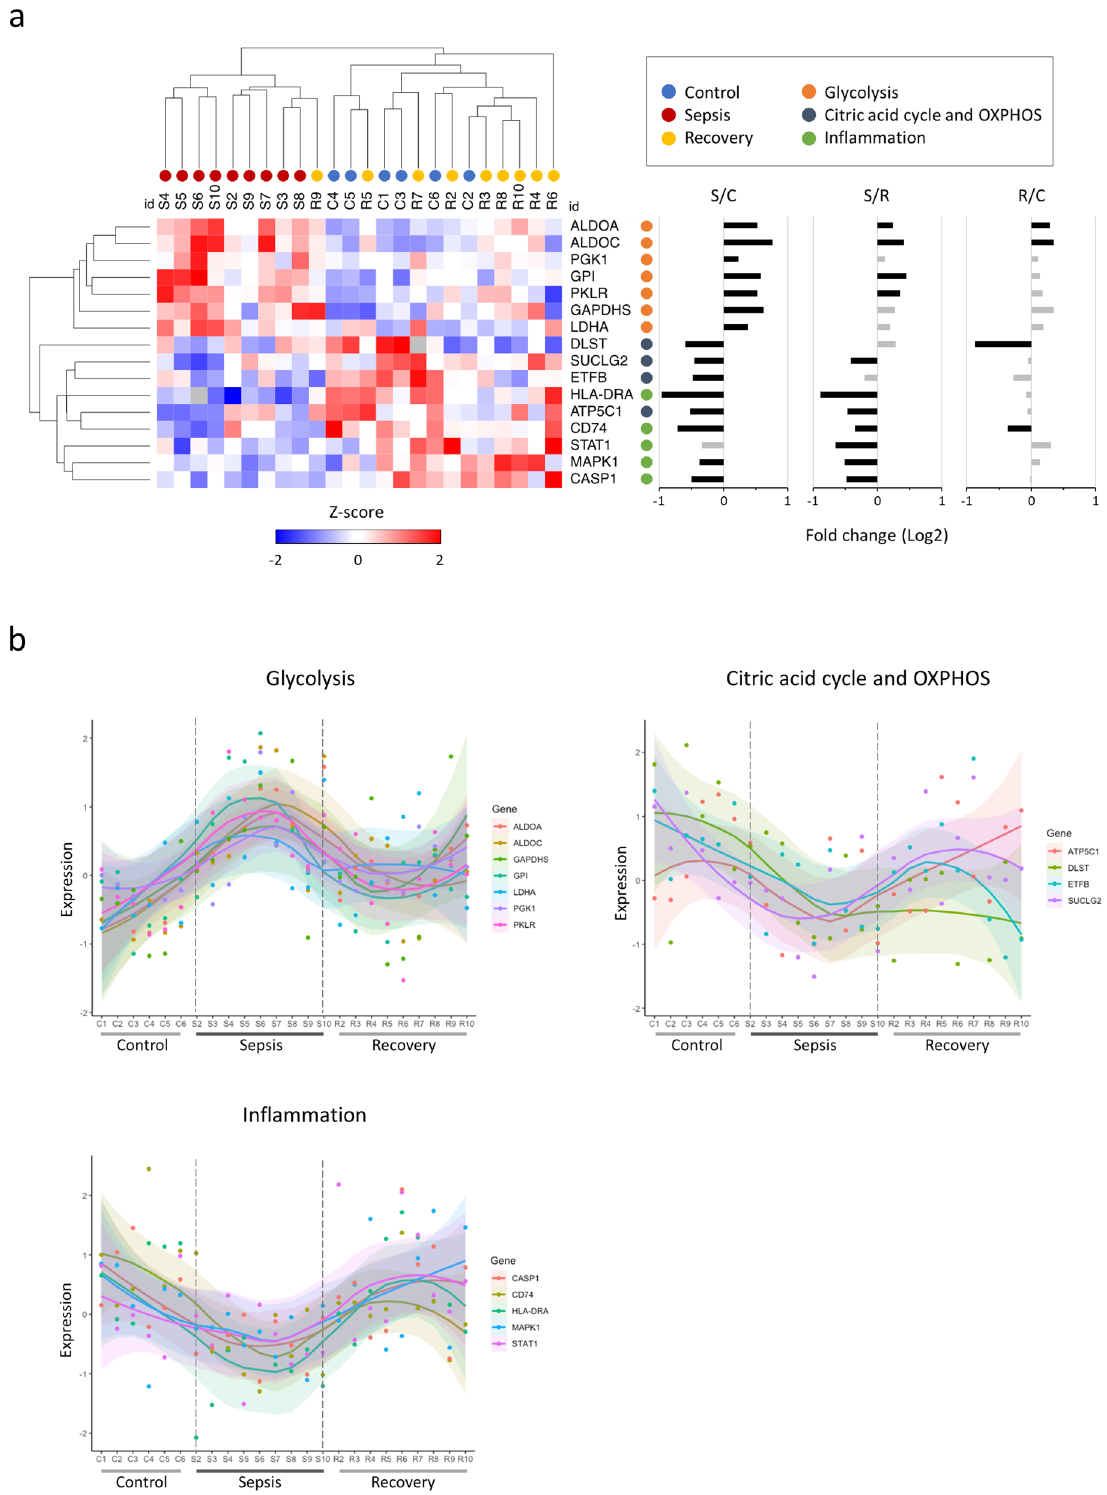
Figure 3. Immunometabolic profile of the experimental groups. ( a ) On the left, the columns (individuals) and rows (proteins) of the heatmap were clustered hierarchically by the Euclidean distance. The expression values were normalized by the z-score of each line. On the right, the fold changes of the protein abundance ratios (NSAF) between the control (C), Sepsis (S), and Recovery (R) groups are displayed. The gray bars represent statistically non-significant differences (TFold); ( b ) Expression (z-scores) of proteins separated by function. The samples were organized on the y axis by the identifier of individuals in the Control group (C1 to C6) followed by the Sepsis (S2 to S10) and Recovery (R2 to R10) groups. Each dot represents a protein with the corresponding smooth line (loess regression) showing each group’s expression